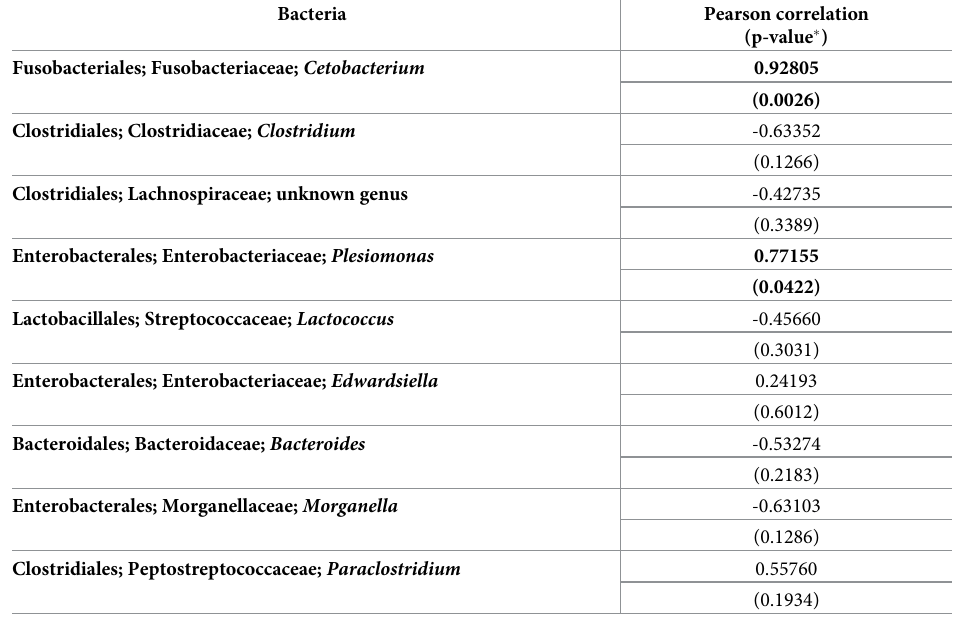
Table 3. Analysis of the pearson correlation to identify the change in bacterial abundance of each genus in the CFCEC with respect to the antibacterial activity. Bacteria Pearson correlation (p-value �